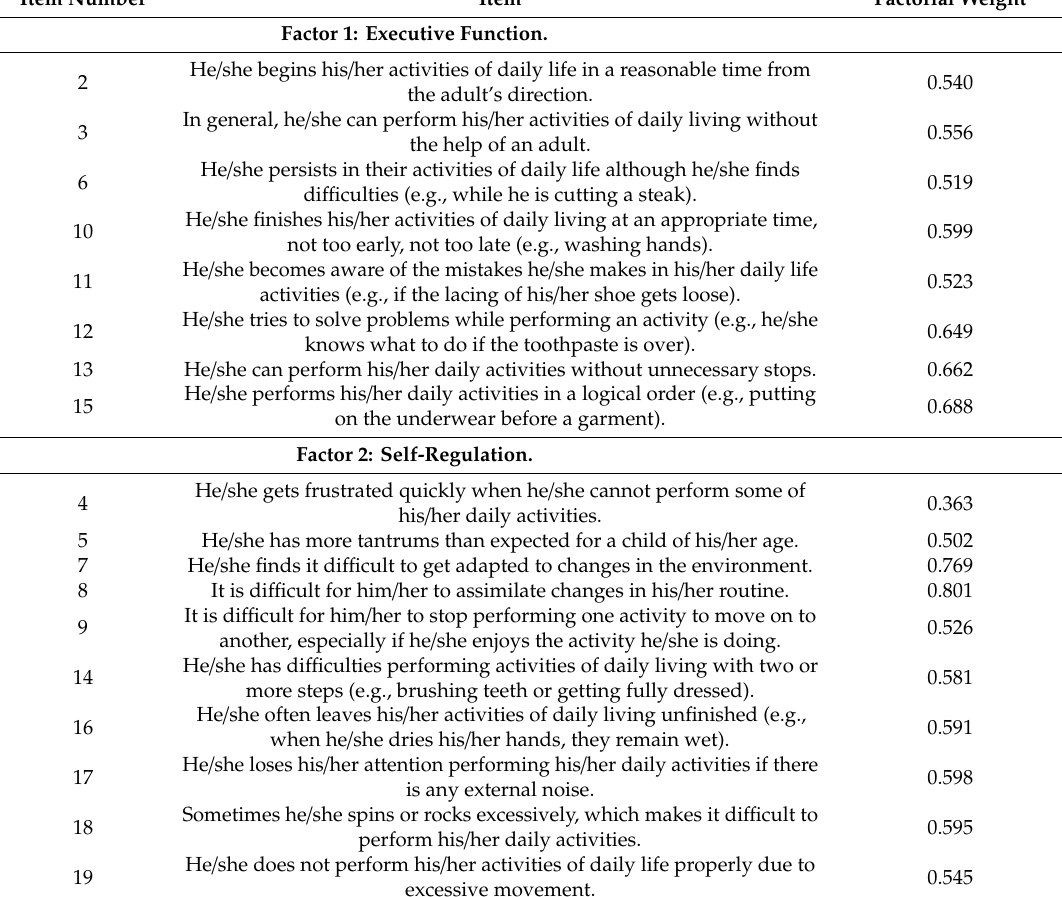
Table 11. General Functioning scale factorial